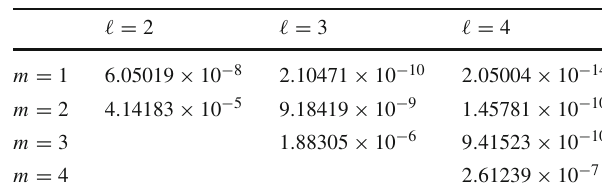
Table 1 The reaction force for different (cid:7) , m modes at 2PM approxi- mation of energy-loss-rate in the EOB theory, the total reaction force F circ ϕ